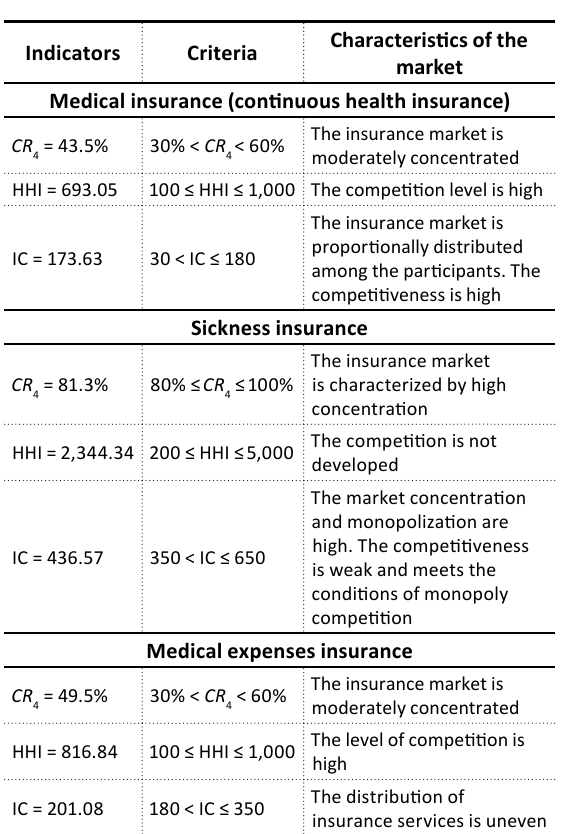
Table 3. Competitiveness indicators of